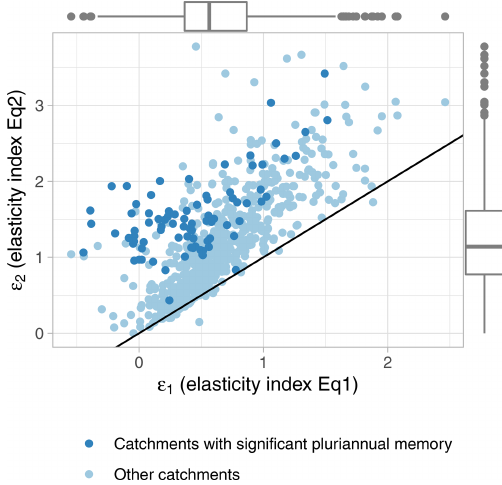
Figure 6. Comparison of elasticity indices found when ignoring multi-year memory effects (Eq. 1) and when explicitly accounting for them (Eq. 2) for all catchments (France and